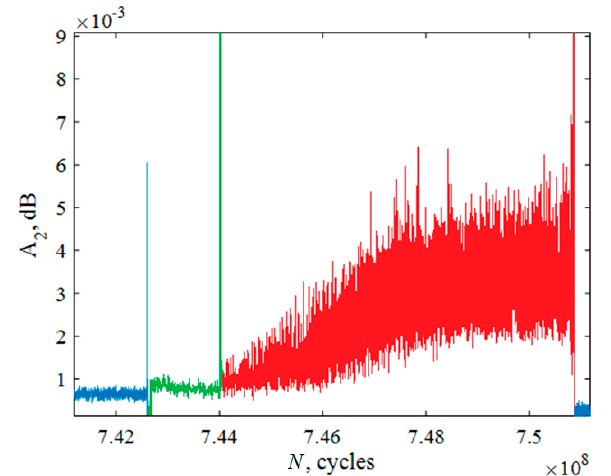
Figure 8. The amplitude of the second harmonic for sample No. 1. Blue color ( N = 7.426 ∙ × 10 8 cy- cles)—damage accumulation and nucleation of fatigue crack site. Green color ( N = 1.4 ∙ × 10 6 cy- cles)—crack grew inside zone 2, formation of “fisheye”. Red color ( N = 6.7 ∙ × 10 6 )—crack grown by Paris law.